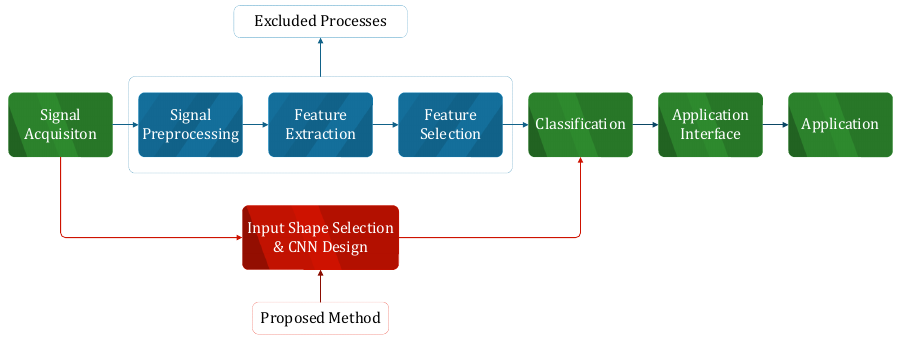
Figure 1. Proposed BCI